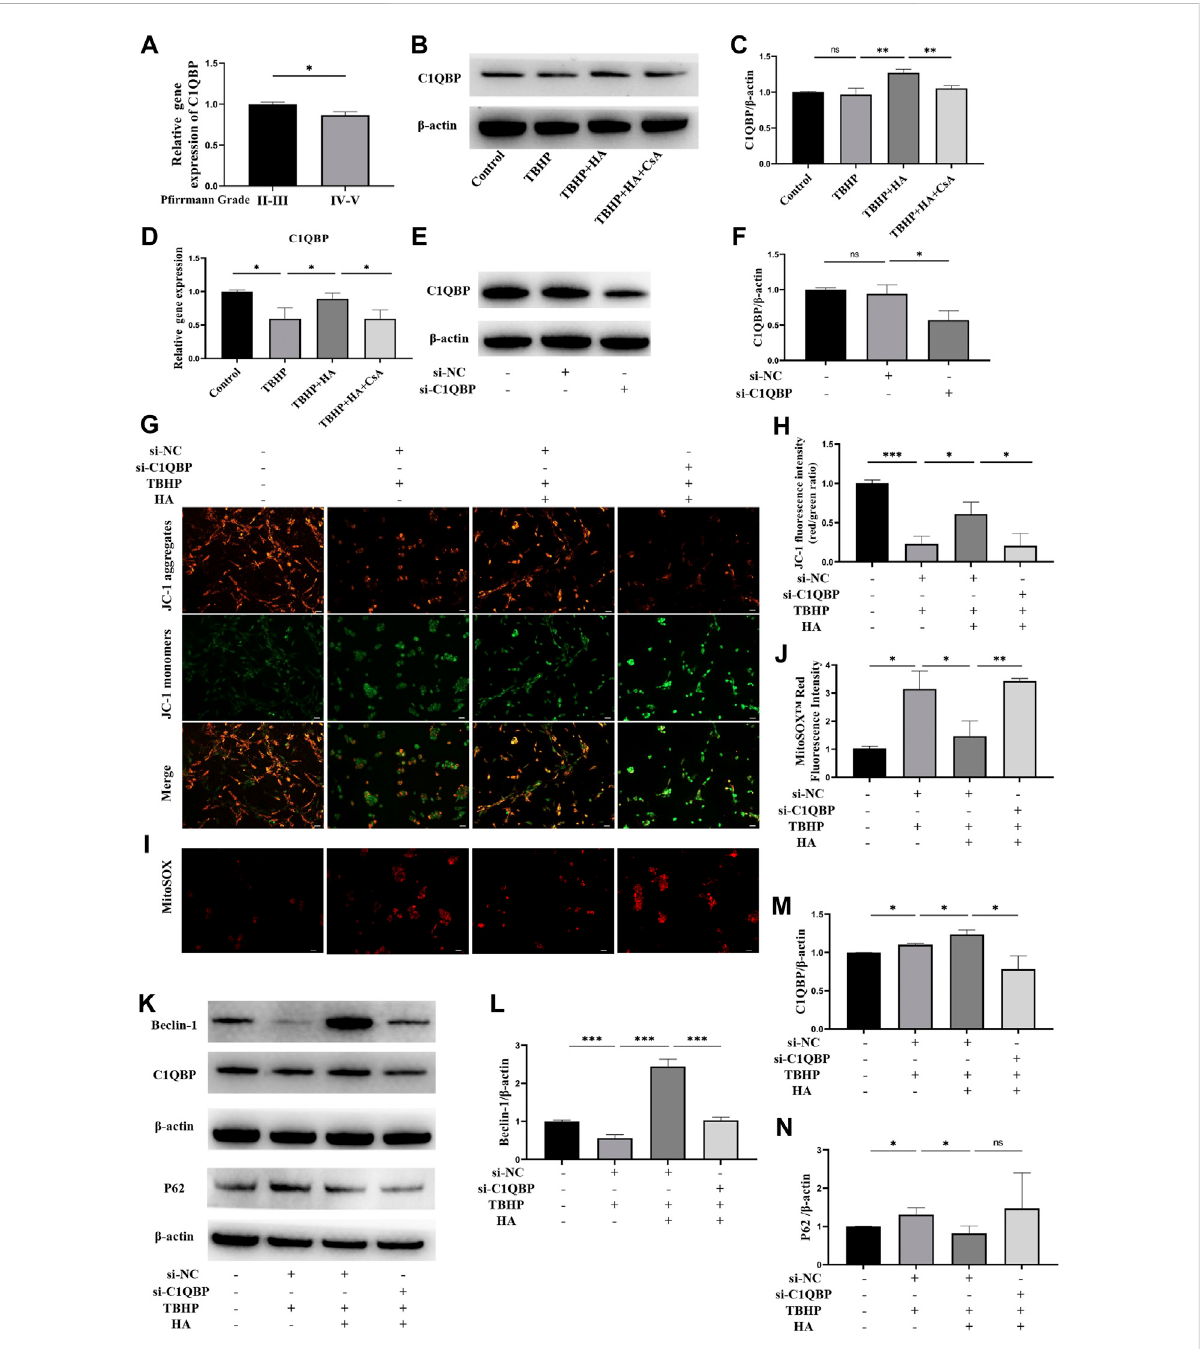
FIGURE 5 The effect of C1QBP on HA protecting mitochondrion function under oxidative stress. (A) Human NP tissues were divided in the mild degeneration group (II-III grade) and the severe degeneration group (IV-V grade) according to the P fi rrmann grading system, the C1QBP mRNA expression between two groups was detected by RT-qPCR. (B – D) The NPCs were treated with HA or CsA before TBHP stimulation, the protein expression of C1QBP was detected by Western blotting, the C1QBP mRNA expression was detected by RT-qPCR. (E,F) The NPCs were transfected with control siRNA (si-NC) or C1QBP siRNA (si-C1QBP), the protein expression of C1QBP was detected by Western blotting. NPCs were transfected with control siRNA or C1QBP siRNA before HA and TBHP treatment. (G,H) Δψ m was measured by JC-1 staining. (I,J) The production of mitochondrial Superoxide was measured by using MitoSOX ™ Red Superoxide Indicator. (K – N) The protein expression of Beclin-1, C1QBP and P62wasdetectedbyWesternblotting.Dataarerepresentedasthemean±SD.ns,notsigni fi cant,* p < 0.05,** p < 0.01,*** p < 0.001.Scalebar:50 μ m n =